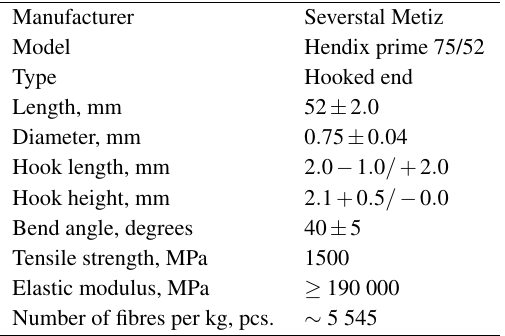
Table 2. Data of the steel fibres, according to [33]